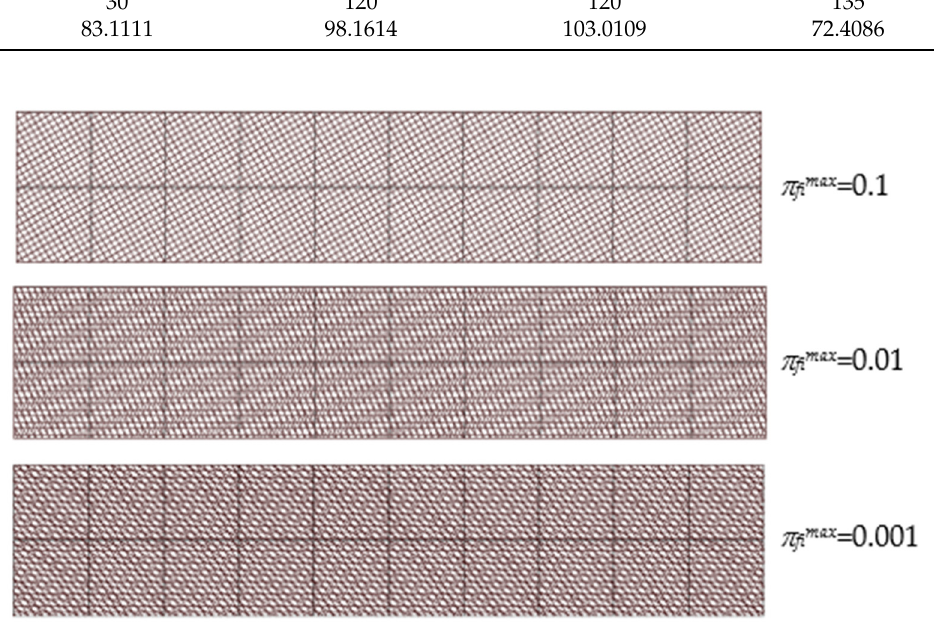
Figure 5. Layout of ply orientation angles on upper and lower wing skin in the composite laminate. The first 10 lowest natural frequency modes used in flutter analysis at each PSI value are presented in the Table 4. From the results shown, the natural frequencies are very high for a wing—even for wind tunnel model testing. This is caused by the strict deformation constraint of 0.1 m, which is less than 2% of half the wings pan. The plots of damping ratio versus velocity with various PSI π fimax values are shown in Figure 6. The results show flutter speeds estimated by quasi-steady aerodynamics, which are affected by PSI π fimax as the lower PSI π fimax results in the lower flutter speeds. Furthermore, from comparing the design variables and the objective functions, the